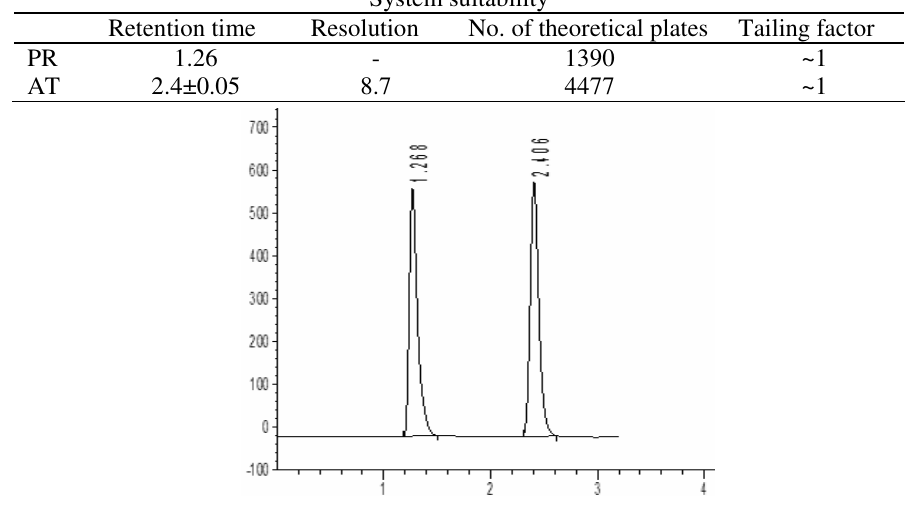
Figure 1. Chromatogram of atorvastatin calcium and internal standard pyridoxine HCl As shown in (Figure 2) the retention times were: 4.0±0.3 min for FL and 1.26 for PR. (Figure 3) shows that the retention time for PV is 1.84±0.1 min and 4.3±0.1 min for the internal standard IB.